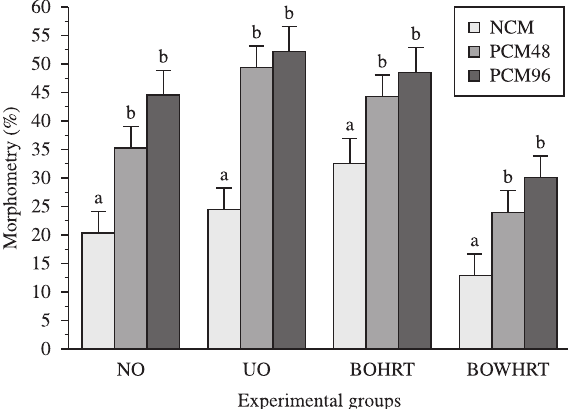
Figure 2. Mean quantity of newly formed bone determined by morphometric analysis. NCM: native collagen matrix; PCM48: polyanionic collagen matrix submitted to alkaline treatment for 48 hours; PCM96: polyanionic collagen matrix submitted to alkaline treatment for 96 hours; NO: non-ovariectomized animals; UO: unilaterally ovariectomized animals; BOWHRT: bilaterally ovariectomized animals not submitted to hormone replacement therapy; BOHRT: bilaterally ovariectomized animals submitted to hormone replacement therapy. p < 0.05 indicates statistical significance.